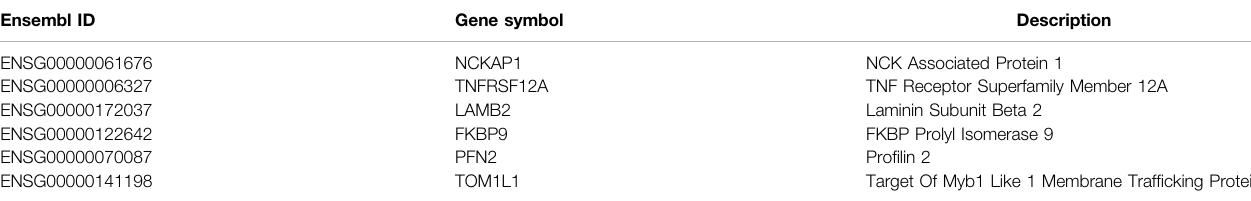
TABLE 3 | Information of essential